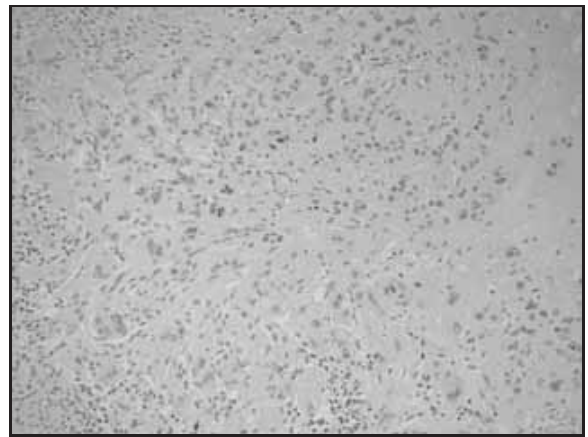
Figure 5 – Epithelioid trophoblastic tumor: immunohistochemical staining showed negativity for